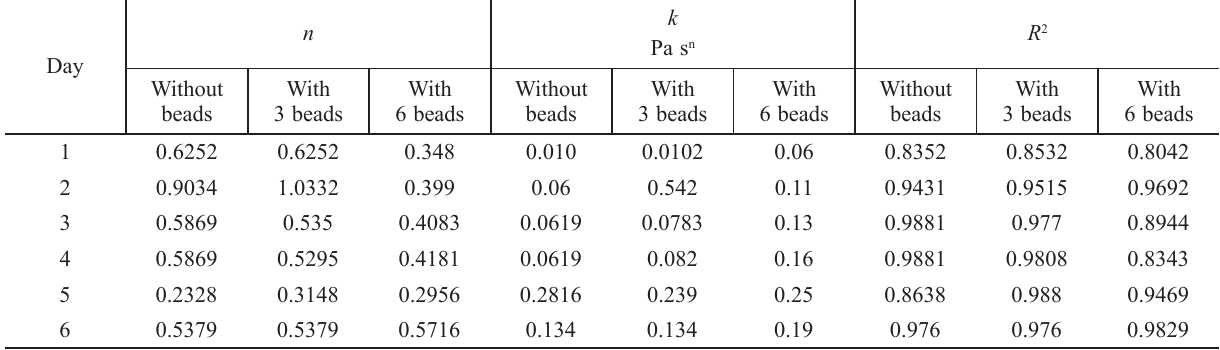
Table 3 – Power law model parameters for cells grown without beads, with 3 beads, and with 6 beads n Day Without